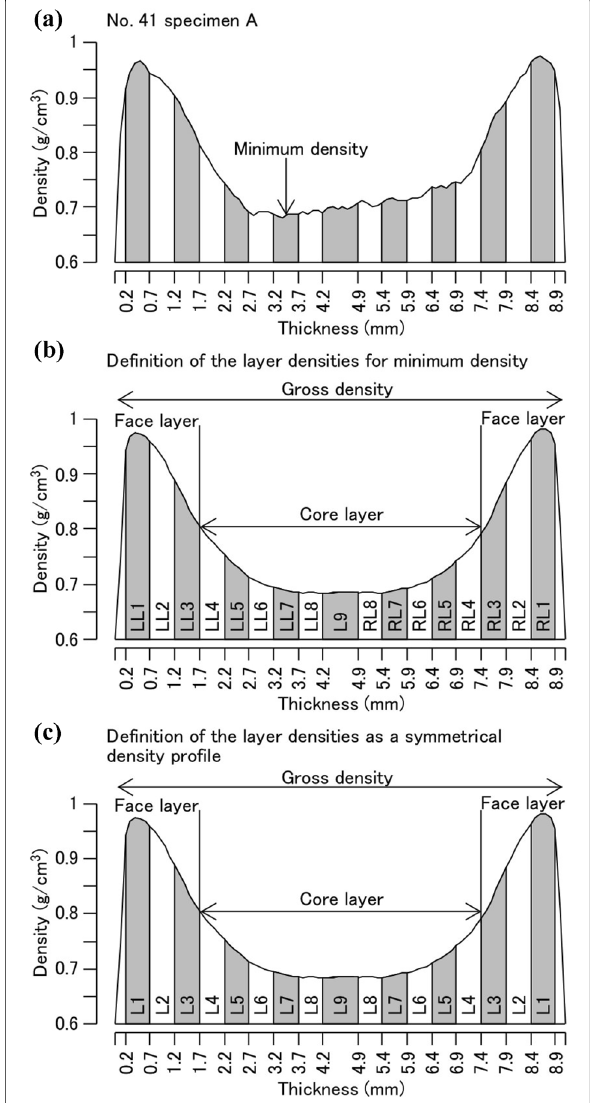
Fig. 2 a A density profile specimen, No. 41 specimen A, was randomly selected as a representative density profile. b Identification of the LL1–RL1 and gross densities in the density profile. The L10 density is the gross density of specimens A and B. c Identification of the L1–L9 and gross densities in the density